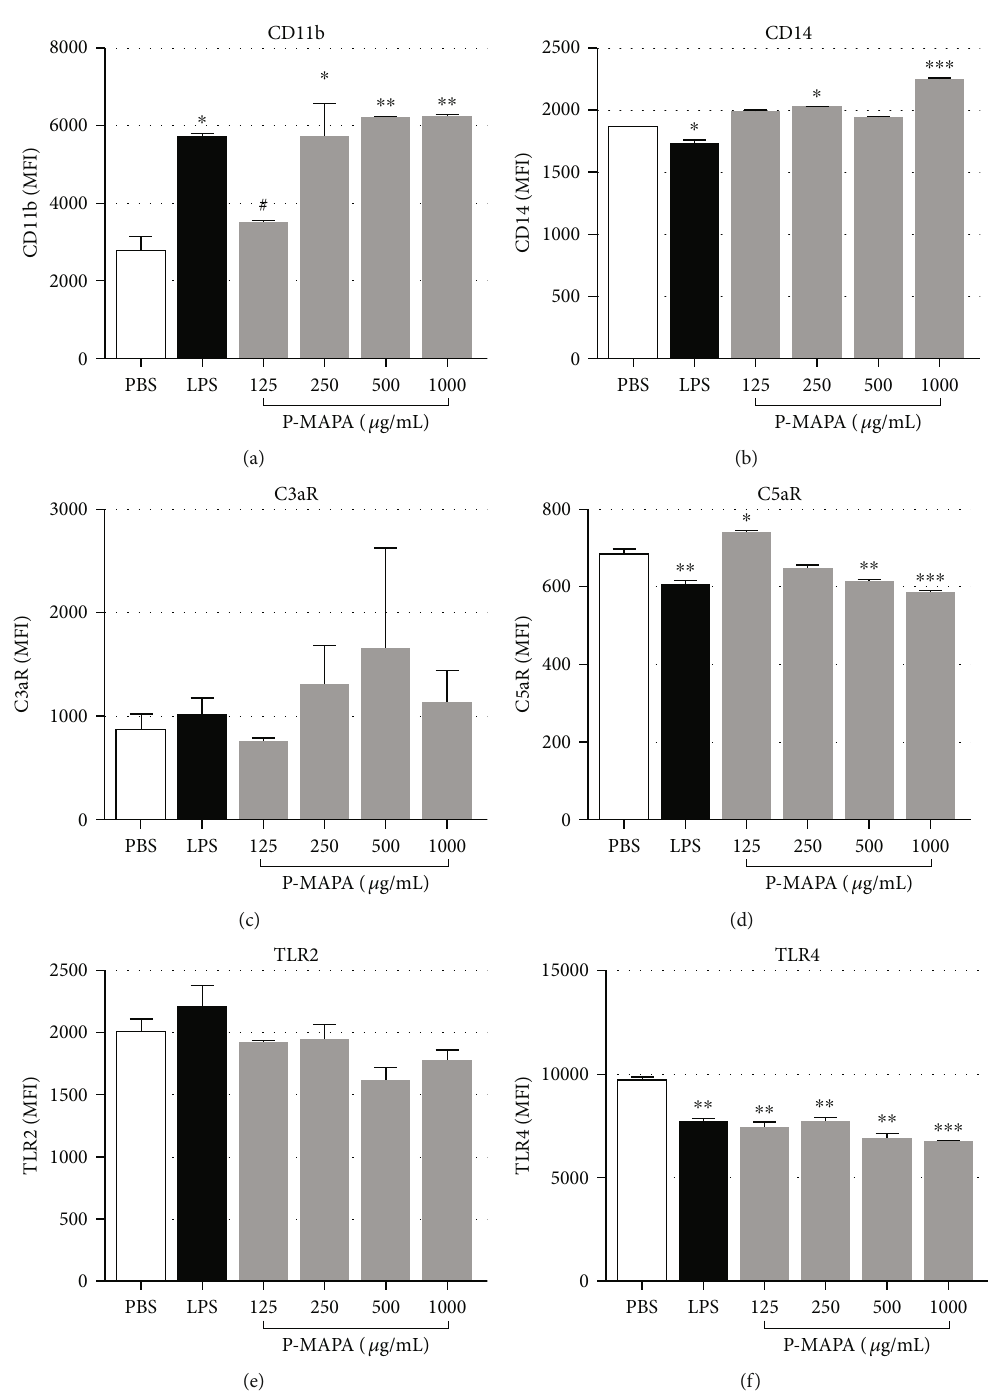
Figure 2: Modulation of surface receptors in monocytes after P-MAPA treatment. After incubation of blood samples with PBS, LPS (100 μ g/mL), or P-MAPA (125, 250, 500, or 1000 μ g/mL) for 30 minutes at 37 ° C, erythrocytes were lysed, and leukocytes were stained for fl ow cytometry analysis. (a) CD11b, (b) CD14, (c) C3aR, (d) C5aR, (e) TLR2, and (f) TLR4 expressions in monocyte population. Data